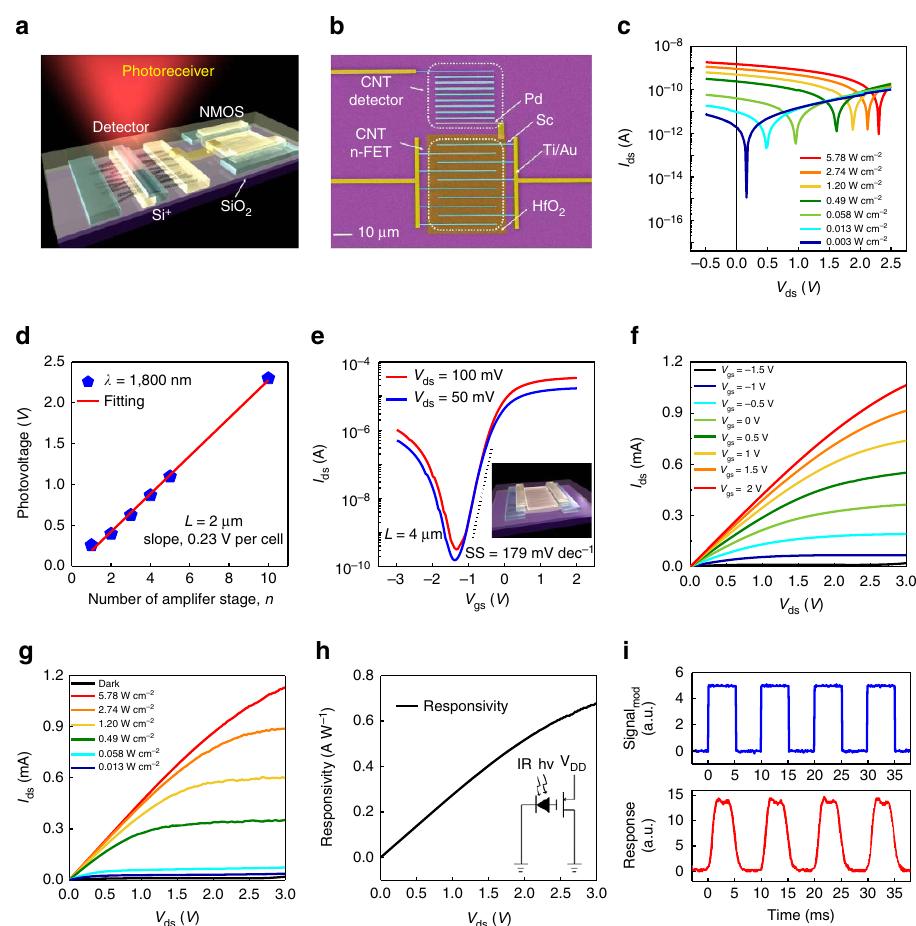
Figure 1 | Structure and performance of the photovoltaic CNT receiver. ( a ) Schematic of the photovoltaic CNT receiver, consisting of a first-stage cascading linear amplifier and a second-stage analogue switch. ( b ) False-colour SEM image of the real photoreceiver, consisting of a nine-cell cascading photodetector and interdigital n-FET (field effect transistor; scale bar, 10 m m). ( c ) Photoresponse of the cascading first-stage amplifier. ( d ) Linearity of the first-stage amplifier versus the amplifier stage number. ( e ) Set of transfer characteristics of the CNT film n-FET with different bias voltages. ( f ) Output characteristics of the n-FET in e measured with V gs varying from 2 to (cid:3) 1.5V. Inset is the schematic top-gate n-FETstructure. ( g ) Output characteristics of the photovoltaic receiver in the dark and under various incident IR illuminations from 5.78 to 0.013Wcm (cid:3) 2 . ( h ) Photocurrent responsivity of the receiver. Inset is the corresponding equivalent circuit diagram. ( i ) Dynamic time trace of the receiver (power density: 5.78Wcm (cid:3) 2 , wavelength: 1,800nm, light source: NKT super-continuous spectrum